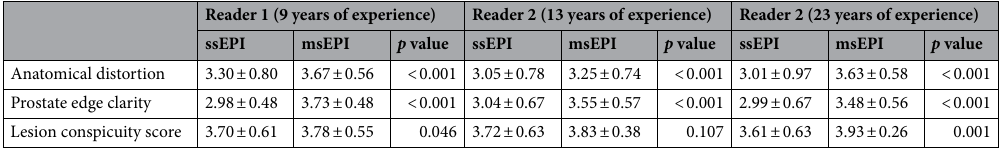
Table 3. Comparison of qualitative indices of image quality and tumor assessment between ssEPI DWI and msEPI DWI.